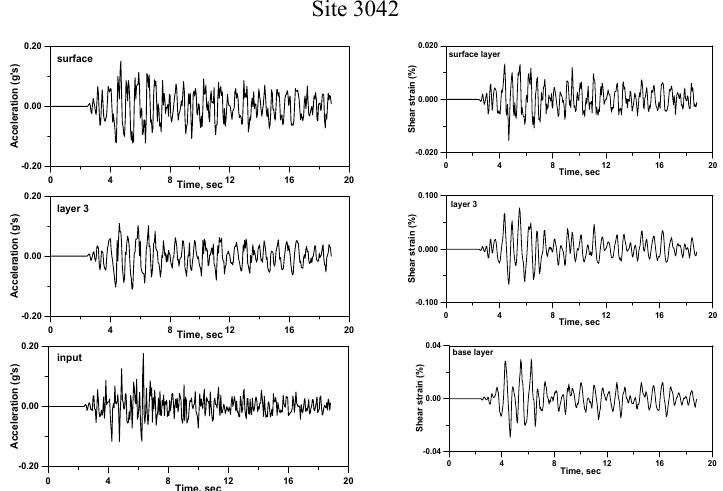
Figure 29 Fig. 29. Acceleration (left column) and strain (right column) time histories at different ground